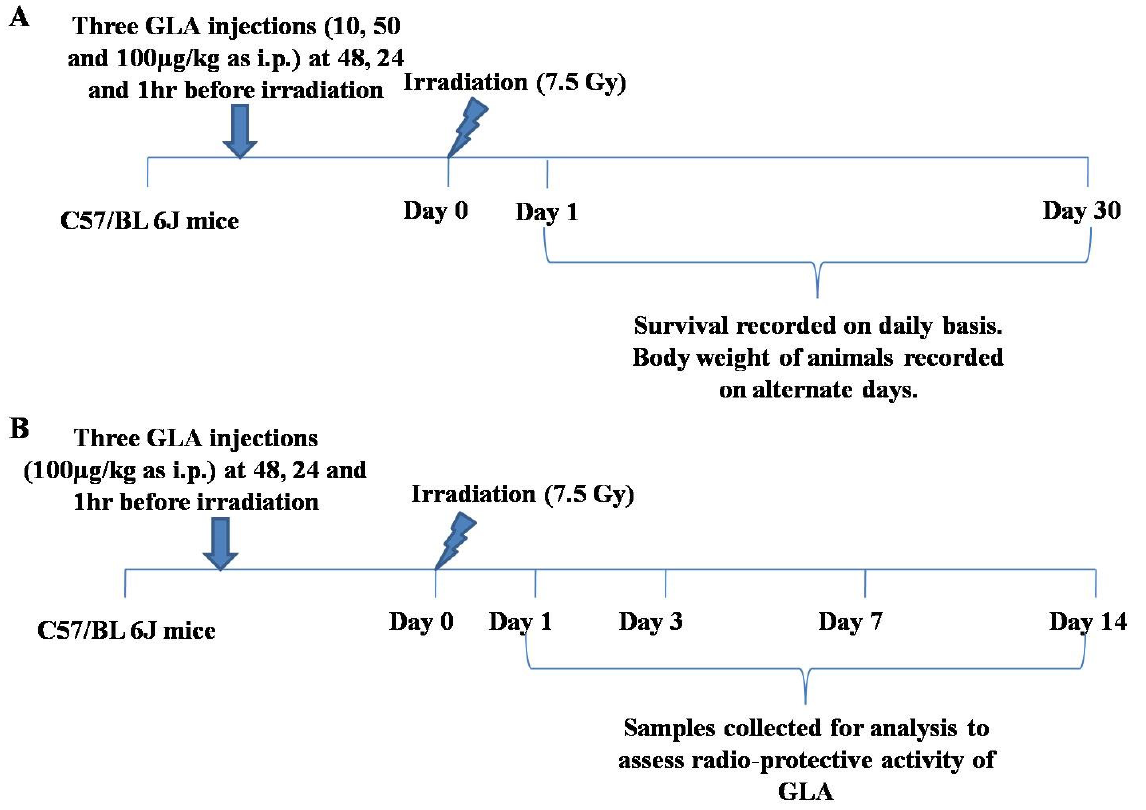
Figure 9. ( A ). Protocol of the in vivo study with radiation and GLA treatment. Mice were pre- acclimatized and treated with GLA (10, 50, and 100 μ g/kg body weight at 48, 24, and 1 h prior to irradiation (7.5 Gy) at a dose rate of 1 Gy/min. ( B ). Protocol for mechanistic studies. Mice were pre- acclimatized and treated with GLA (100 μ g/kg body weight at 48, 24, and 1 h prior to irradiation (7.5 Gy) at a dose rate of 1 Gy/min. Samples were collected from mice on days 1, 3, 7, and 14 for further analysis.